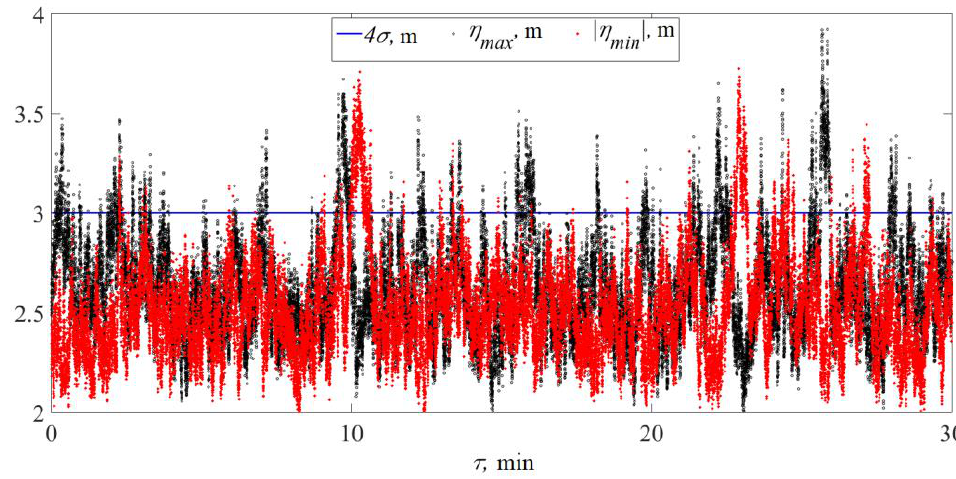
Figure 3. Maximum wave field and module of minimum wave field in each time moment.